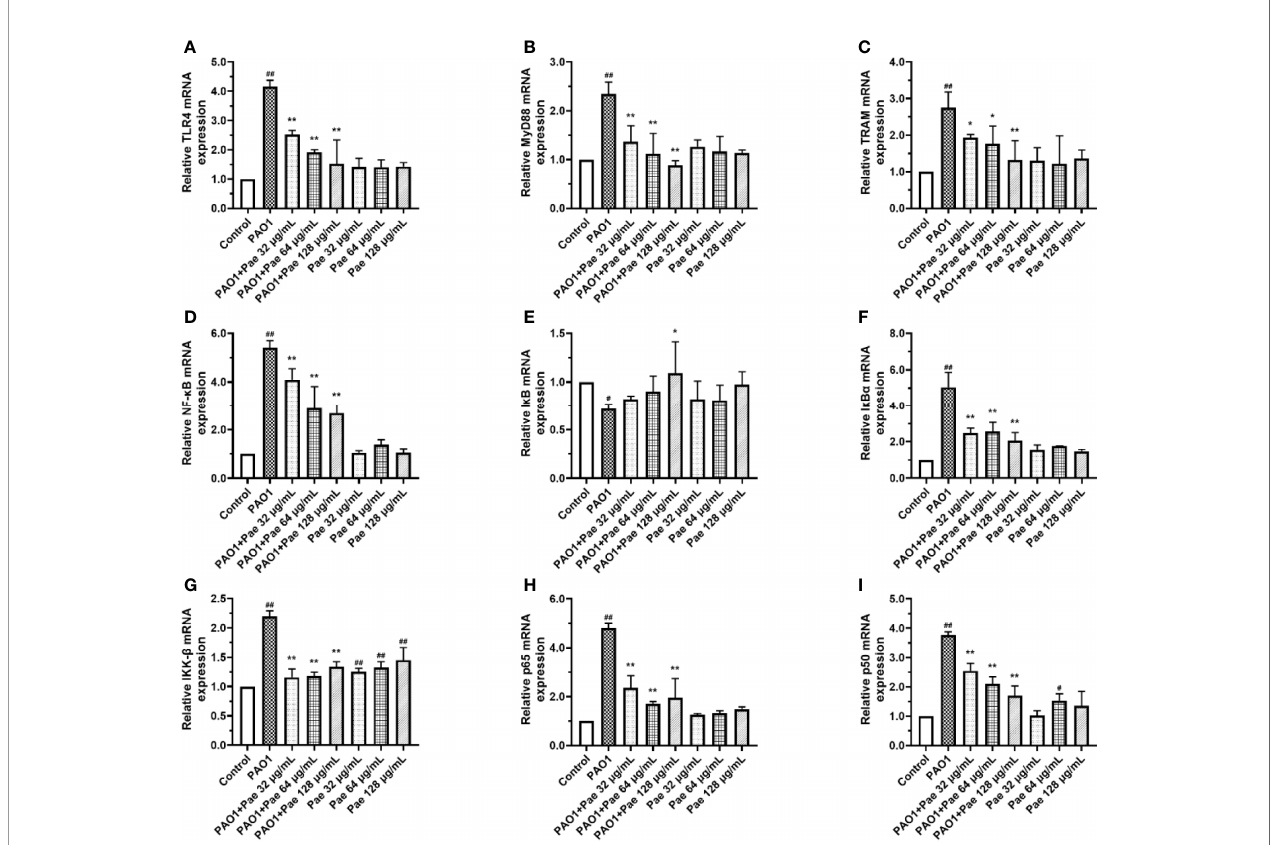
FIGURE 10 | Paeonol inhibited the activation of TLR4/MyD88/NF- k B pathway in PAO1 infected RAW264.7 (MOI = 100:1). RAW264.7 were exposed to PAO1 treated without or with paeonol for 4 h to determine the mRNA expression levels of the TLR4/MyD88/NF- k B pathway. (A) TLR4, (B) MyD88, (C) TRAM, (D) NF- k